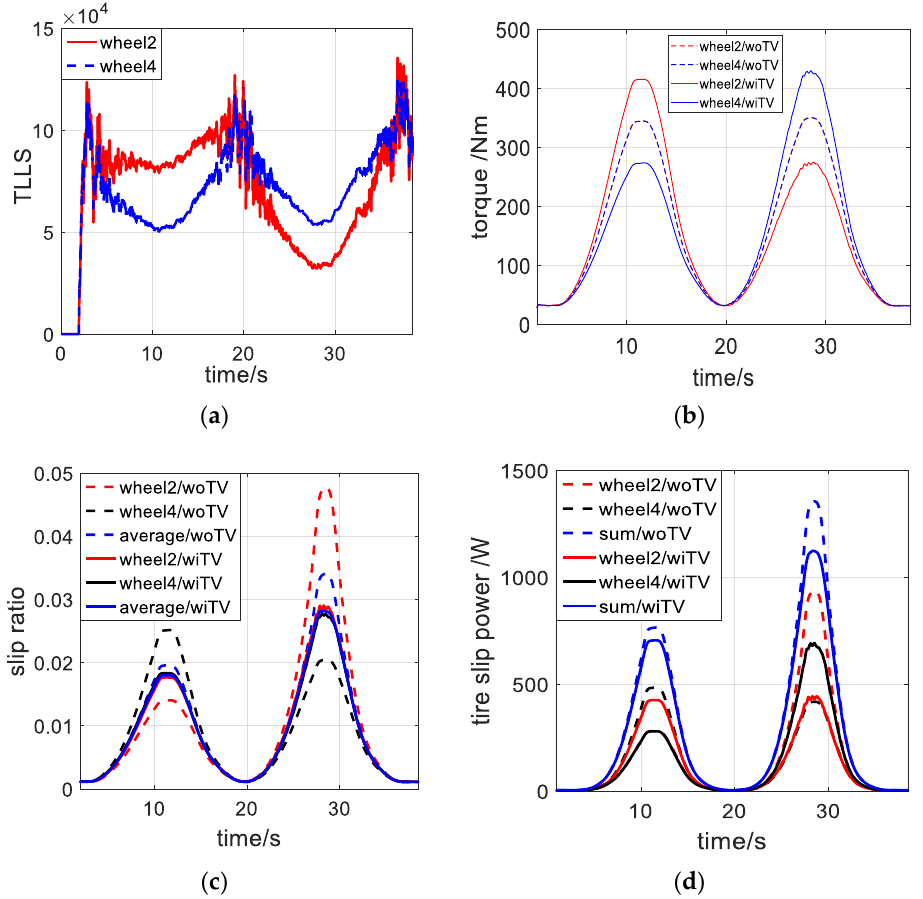
Figure 11. The lemniscate-shape path simulation: ( a ) TLLS.; ( b ) torque; ( c ) the slip ratio; ( d ) the slip power consumption.